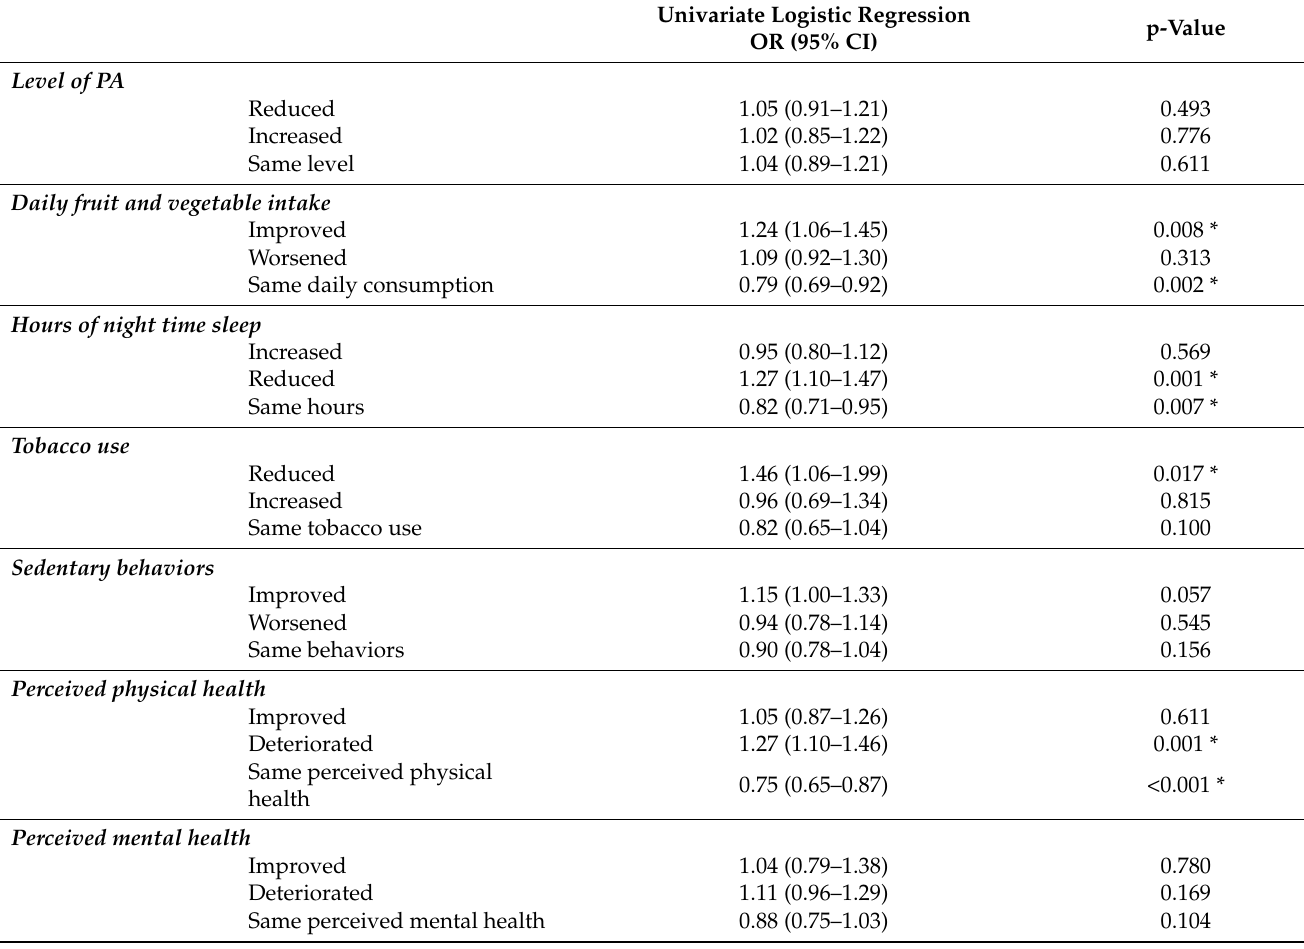
Table 4. Association between NCDs and healthy lifestyle behaviors and perceived mental and physical health during the COVID-19 pandemic (Predicted Probability) using univariate logistic regression analysis. Univariate Logistic